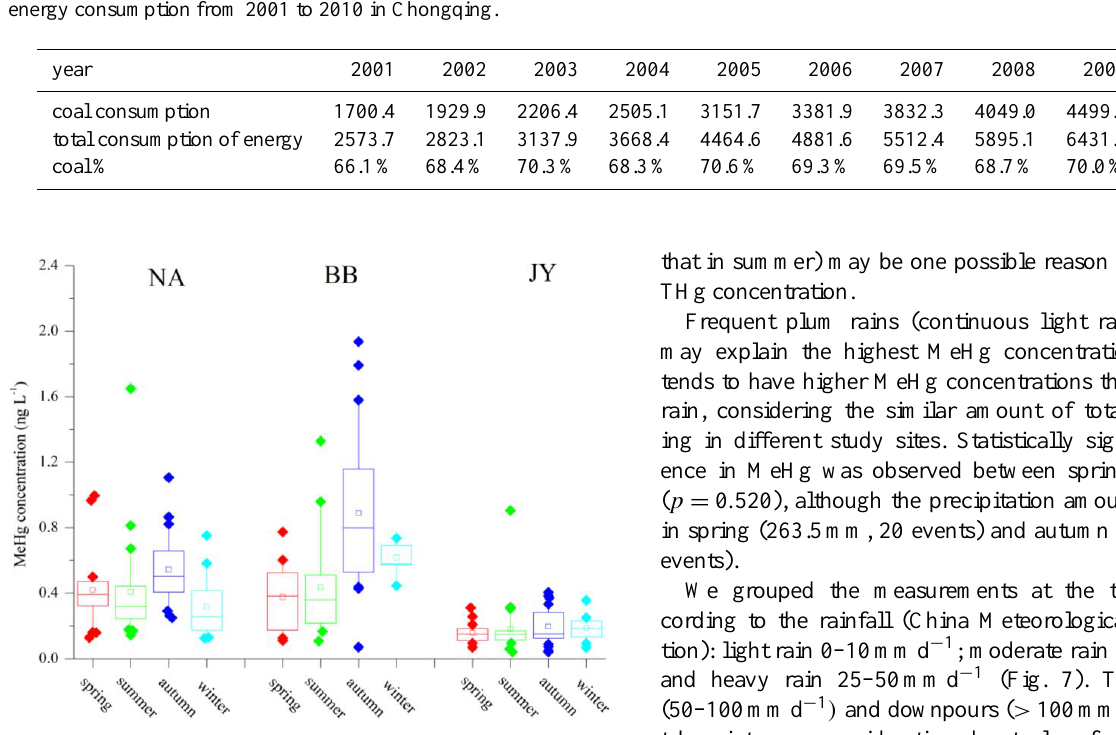
Fig. 5. MeHg concentrations in all precipitation samples at three sampling sites over